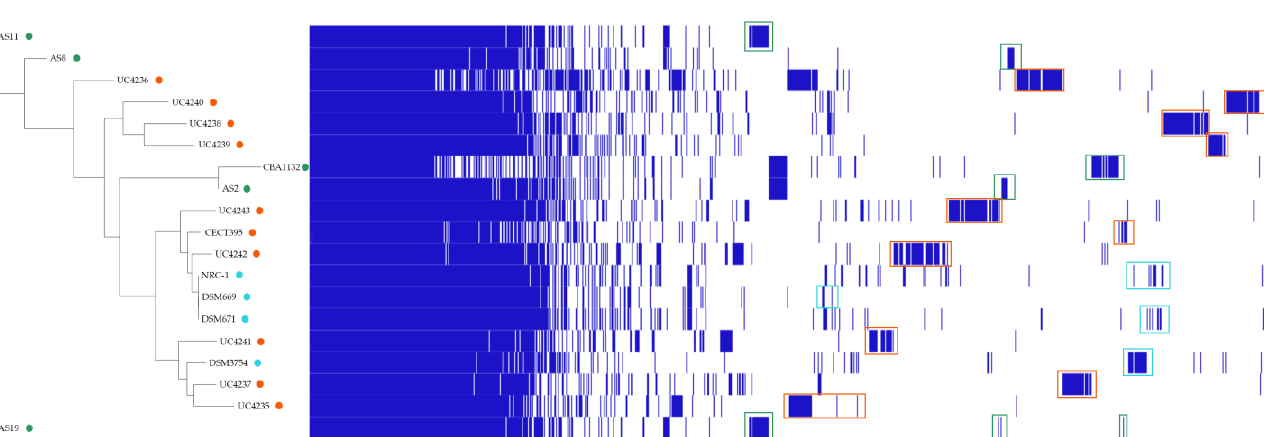
Figure 1. ( a ) Venn diagram representing the percentage of shared and niche-specific genes within H. salinarum pangenome. ( b ) PCoA based on the gene presence/absence matrix and isolation source category (labelled as food, animal, and environmental) of the H. salinarum strains investigated. The distance between niche labels represents the dissimilarity in the genetic content of the isolates in relation to their isolation source.